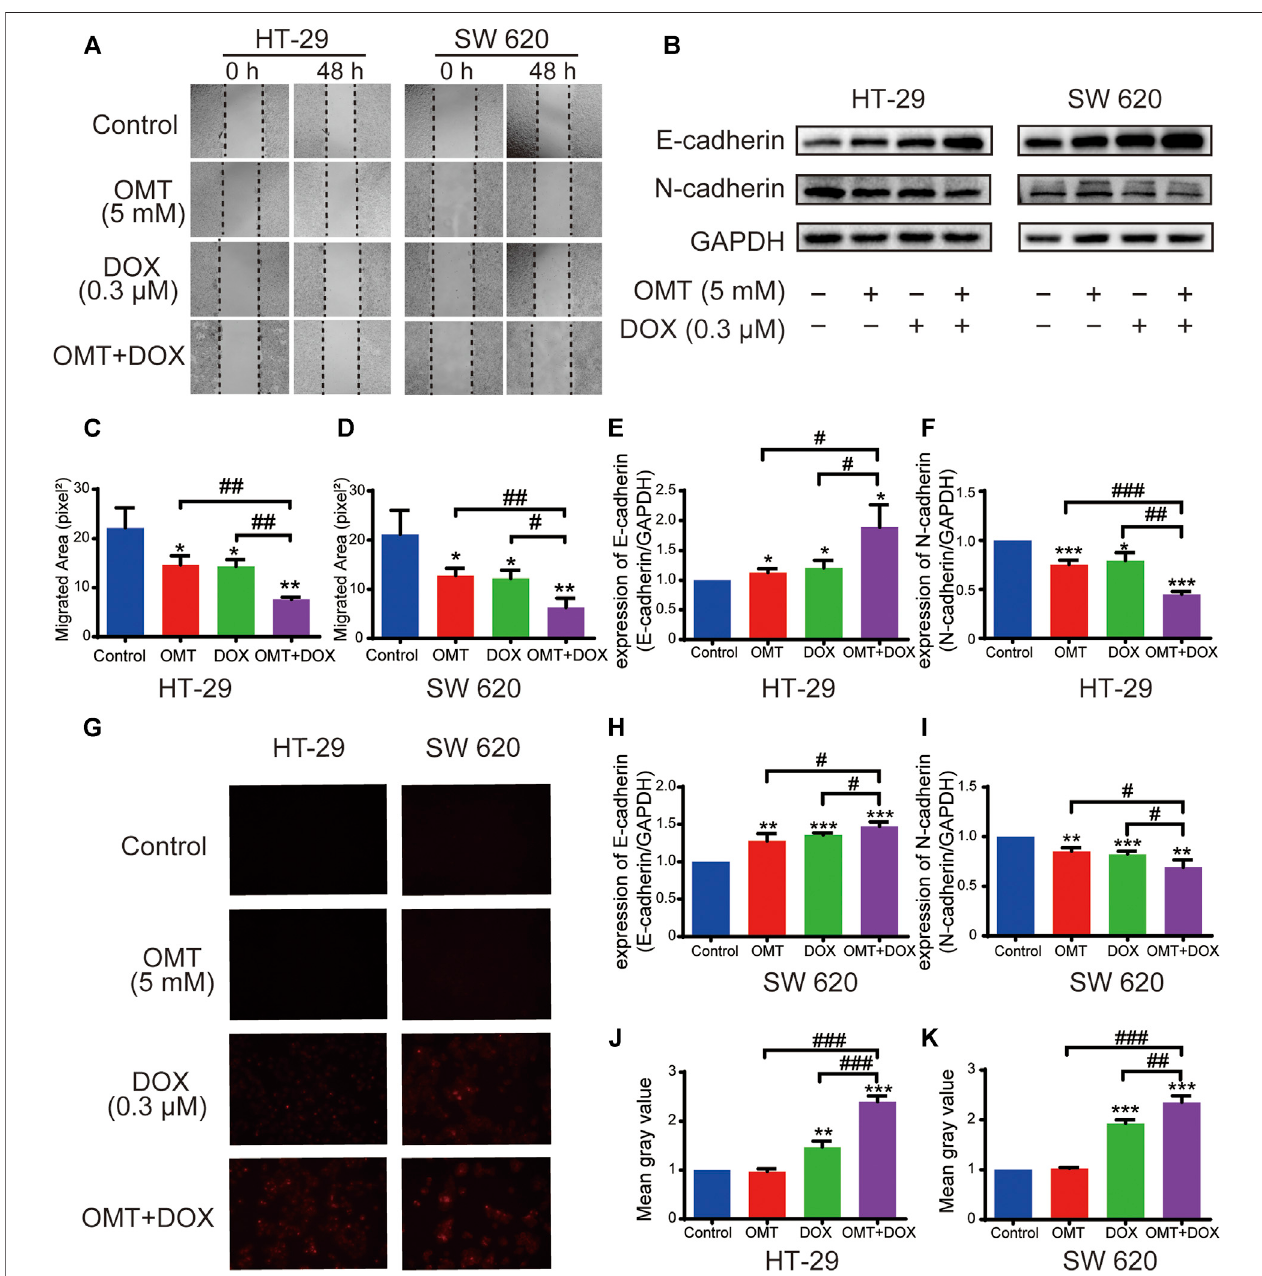
FIGURE 4 | OMT combined with DOX inhibited migration of CRC cells. (A) Wound healing assay of HT-29 and SW620 cells following treatment with OMT or/and DOX.Imageswerecapturedat0and48 hafterwoundingthecelllayer(magni fi cation, × 50). (B) WesternblottingassaywasusedtoanalyzetheexpressionofE-cadherin and N-cadherin. (C,D) The wound healing rate of HT-29 and SW620 cells was expressed as percentage of the scratch area. (E,F) The densitometry analysis of each protein was performed and normalized with the corresponding GAPDH content. (G) Uptake of Dox in HT-29 and SW620 cells was observed under fl uorescence microscopy.Thered fl uorescenceindicatesDOX. (H,I) ThedensitometryanalysisofeachfactorwasperformedandnormalizedwiththecorrespondingGAPDHcontent. (J,K) ImageJwas used tocalculate theaverage fl uorescence intensity ofDOX.Dataarepresentedasthe mean ± SDofthree independentexperiments. * p < 0.05, ** p < 0.01, *** p < 0.001 vs. the control group; # p < 0.05, ## p < 0.01, ### p < 0.001 vs. the OMT (5 mM) group or DOX (0.3 μ M) group.